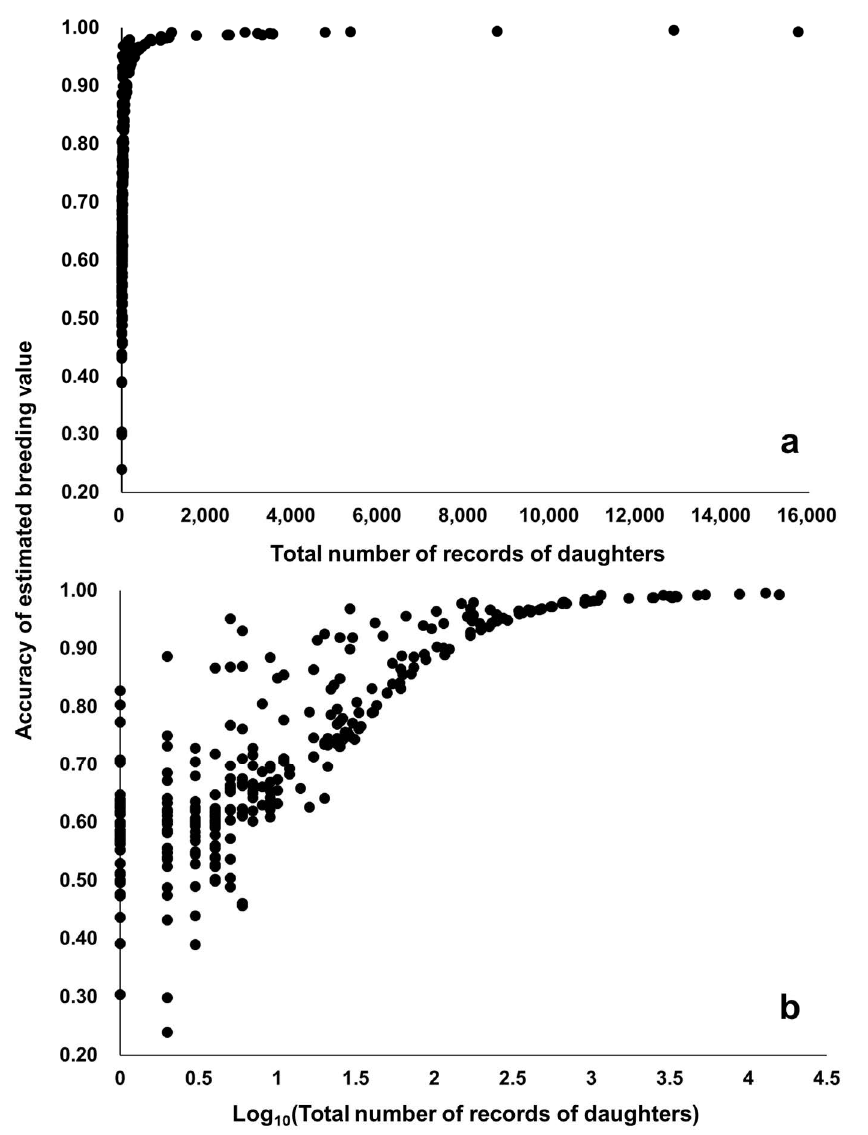
Figure 6. Accuracy of estimated breeding values for 314 sires by repeatability model analysis. The total number of records of daughters are in the original scale ( a ) and the logarithmic scale ( b ).